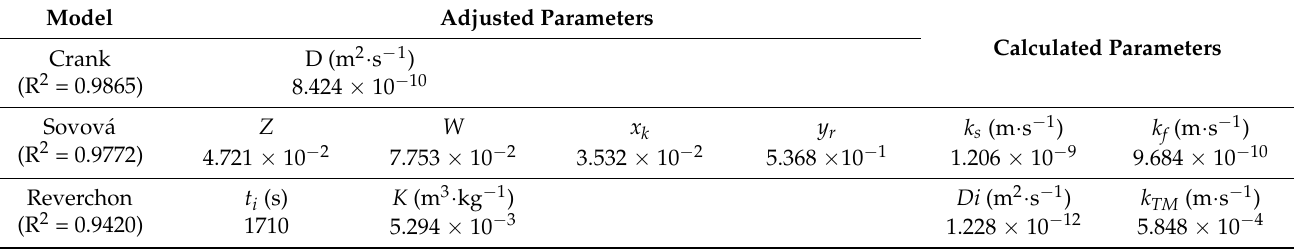
Figure 4. The yield curve for supercritical fluid extraction at 40 °C, 279 bar, and milled flower (42 mesh): mathematical models and experimental data. Table 5. Adjusted and calculated parameters for mathematical models of mass transfer.